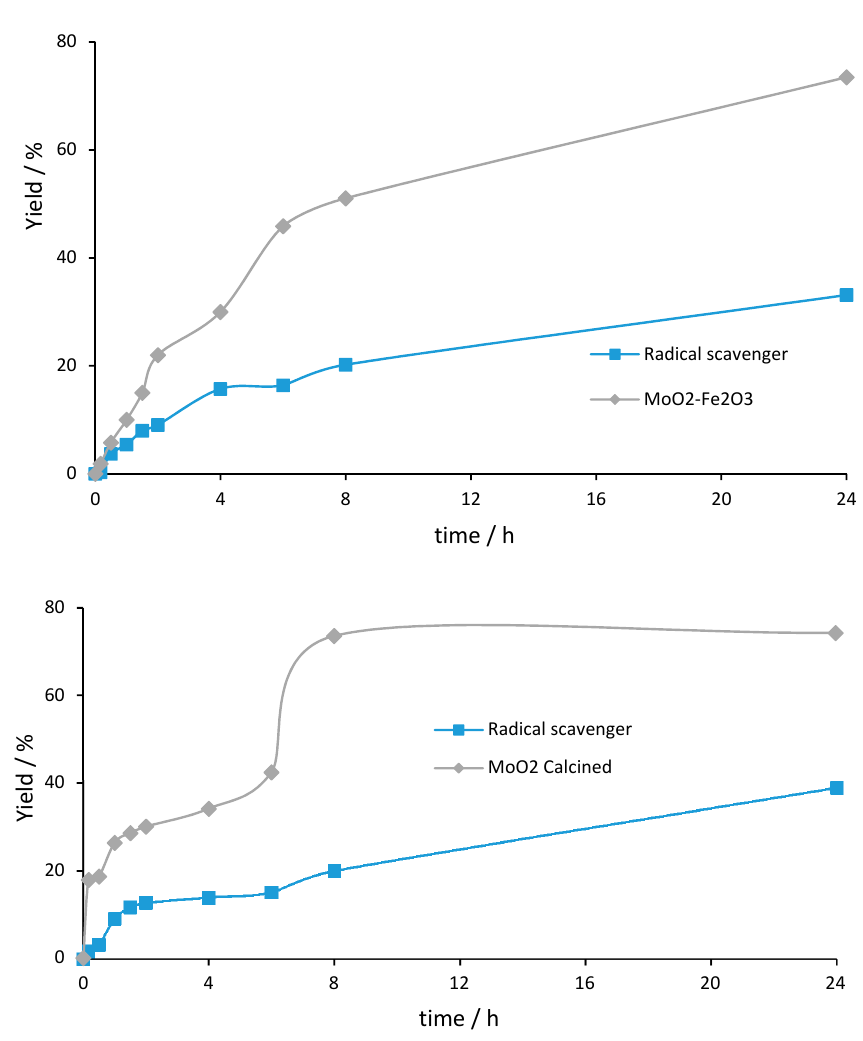
Figure 5. Use of a radical scavenger, with 200% TBHP and MoO 2 –Fe 2 O 3 ( top ) and MoO 2 calcined ( bottom ) as catalysts.